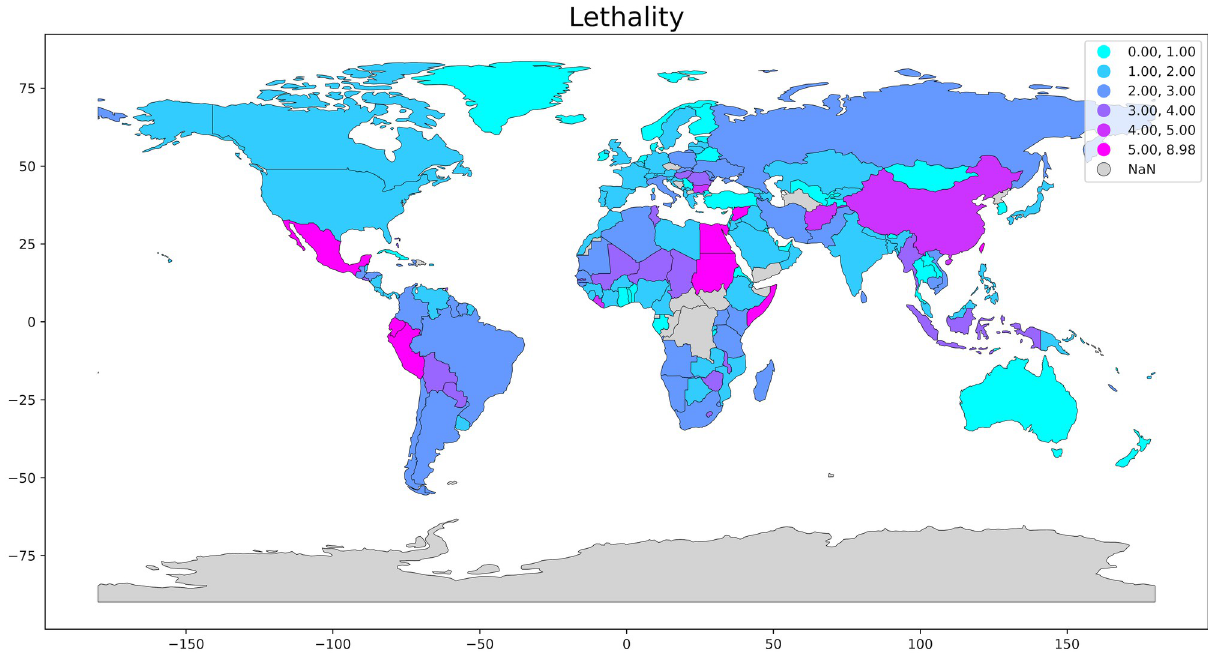
Fig 2. Lethality [(Reported COVID-19 deaths)/(Reported COVID-19 cases)] per country. We made use of the GISAID platform’s data to estimate COVID lethality and genome sharing per 10 5 inhabitants. We obtained the geospatial data for plotting the map in the open-source software library written for the Python programming language, Geopandas. The areas in grey are without reported data.